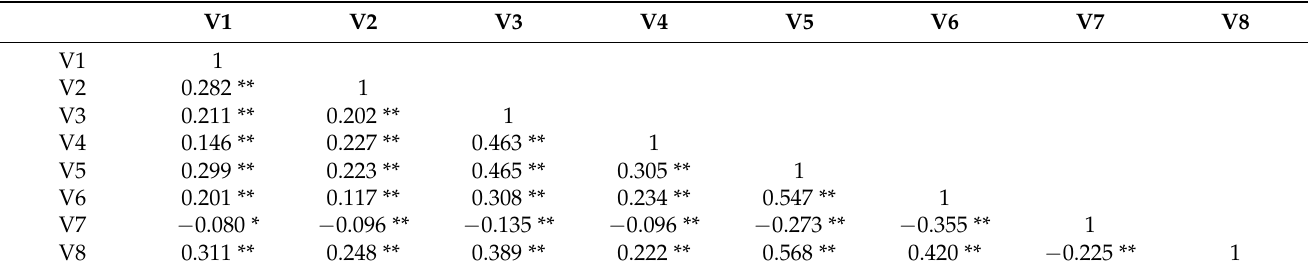
Table 2. Correlation of variables ( n = 1150).